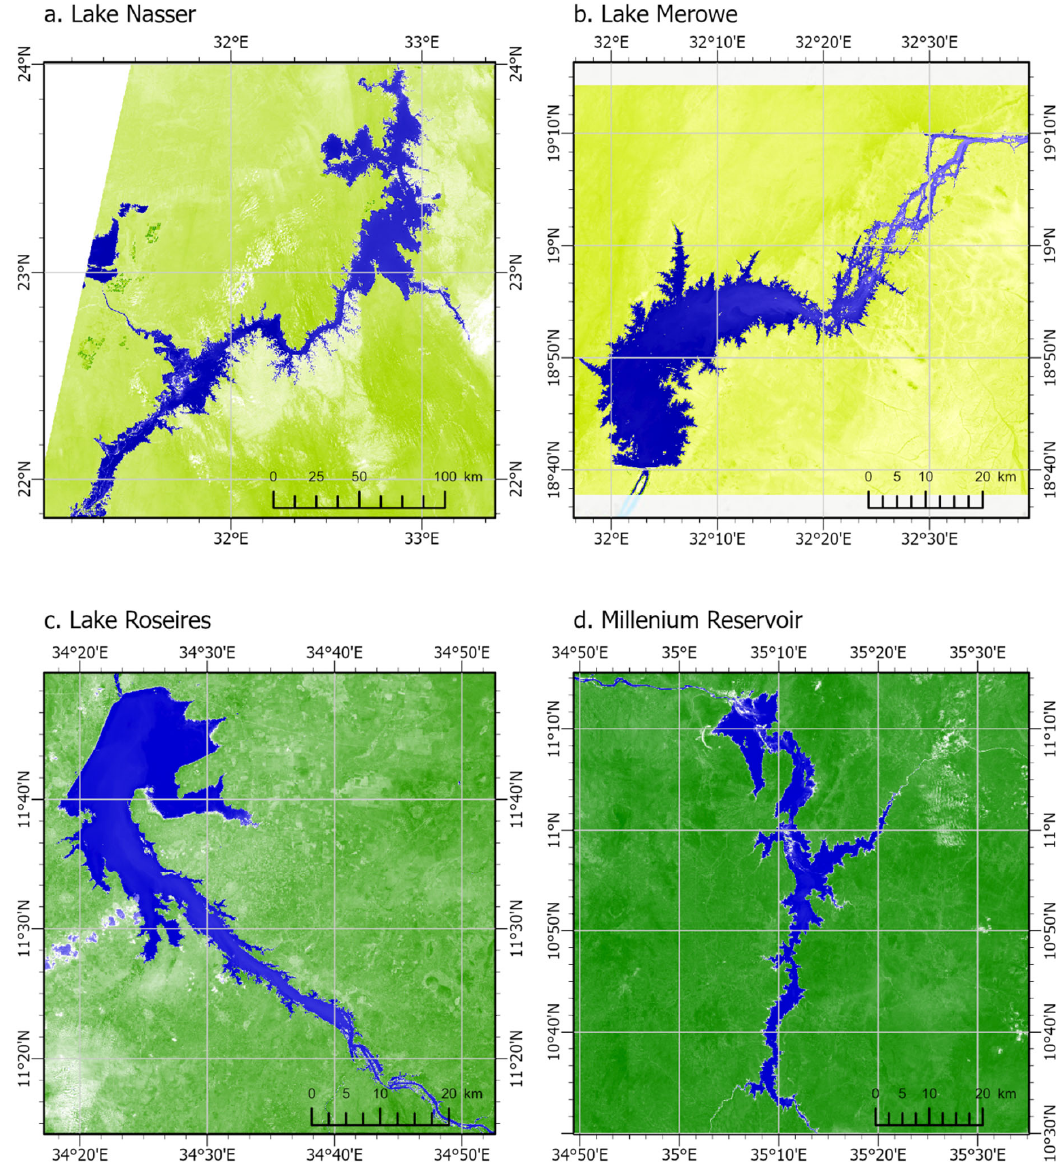
Figure 3. Surface water extent extracted using the water mask created from the NDWI using cloud ‐ free Sentinel ‐ 2 images. The images show the surface water extent of four reservoirs in the Nile Basin, ( a ) Lake Nasser, ( b ) Lake Merowe, ( c ) Lake Roseires, and ( d ) Millennium Reservoir, after the peak flooding season corresponding to late October. These images correspond to the dates 20–31 October 2021, representing post ‐ peak flooding surface water extents in the different reservoirs.